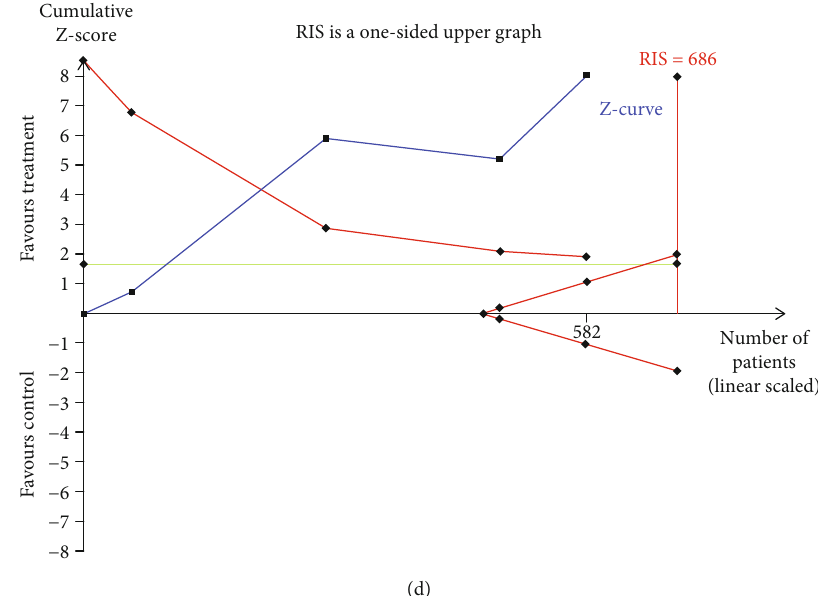
Figure 7: (a) Forest plots of the e ff ect of oral iron on serum ferritin; (b) subgroup analysis of treatment frequency on serum ferritin; (c) subgroup analysis of treatment duration on serum ferritin; (d) trial sequential analysis of serum